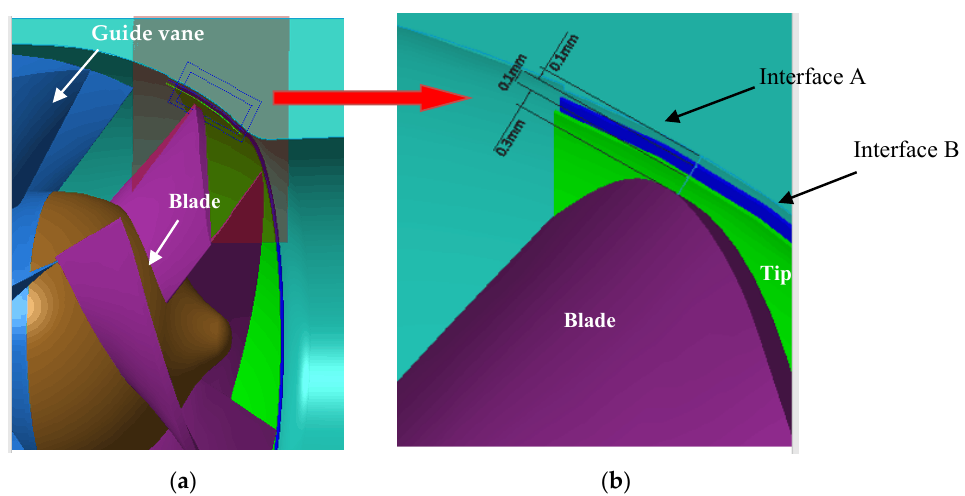
Figure 4. The position of the interface when eccentricity e is 0.3 mm. ( a ) The position of the domain and interface; ( b ) The detail of blade tip.